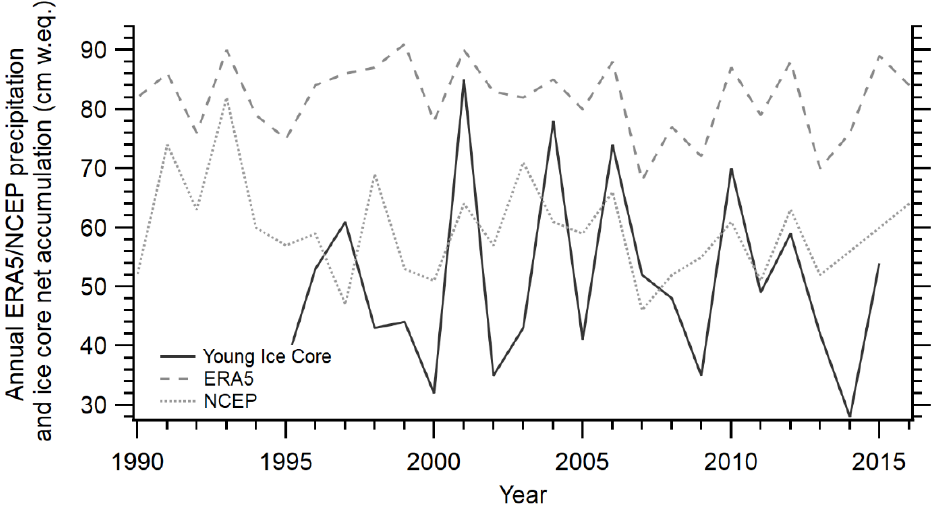
Figure 13. Interannual comparison of precipitation derived from ERA5 and NCEP reanalyses to ice core net accumulation derived from annual layer thickness (based on marine species dating approach C).